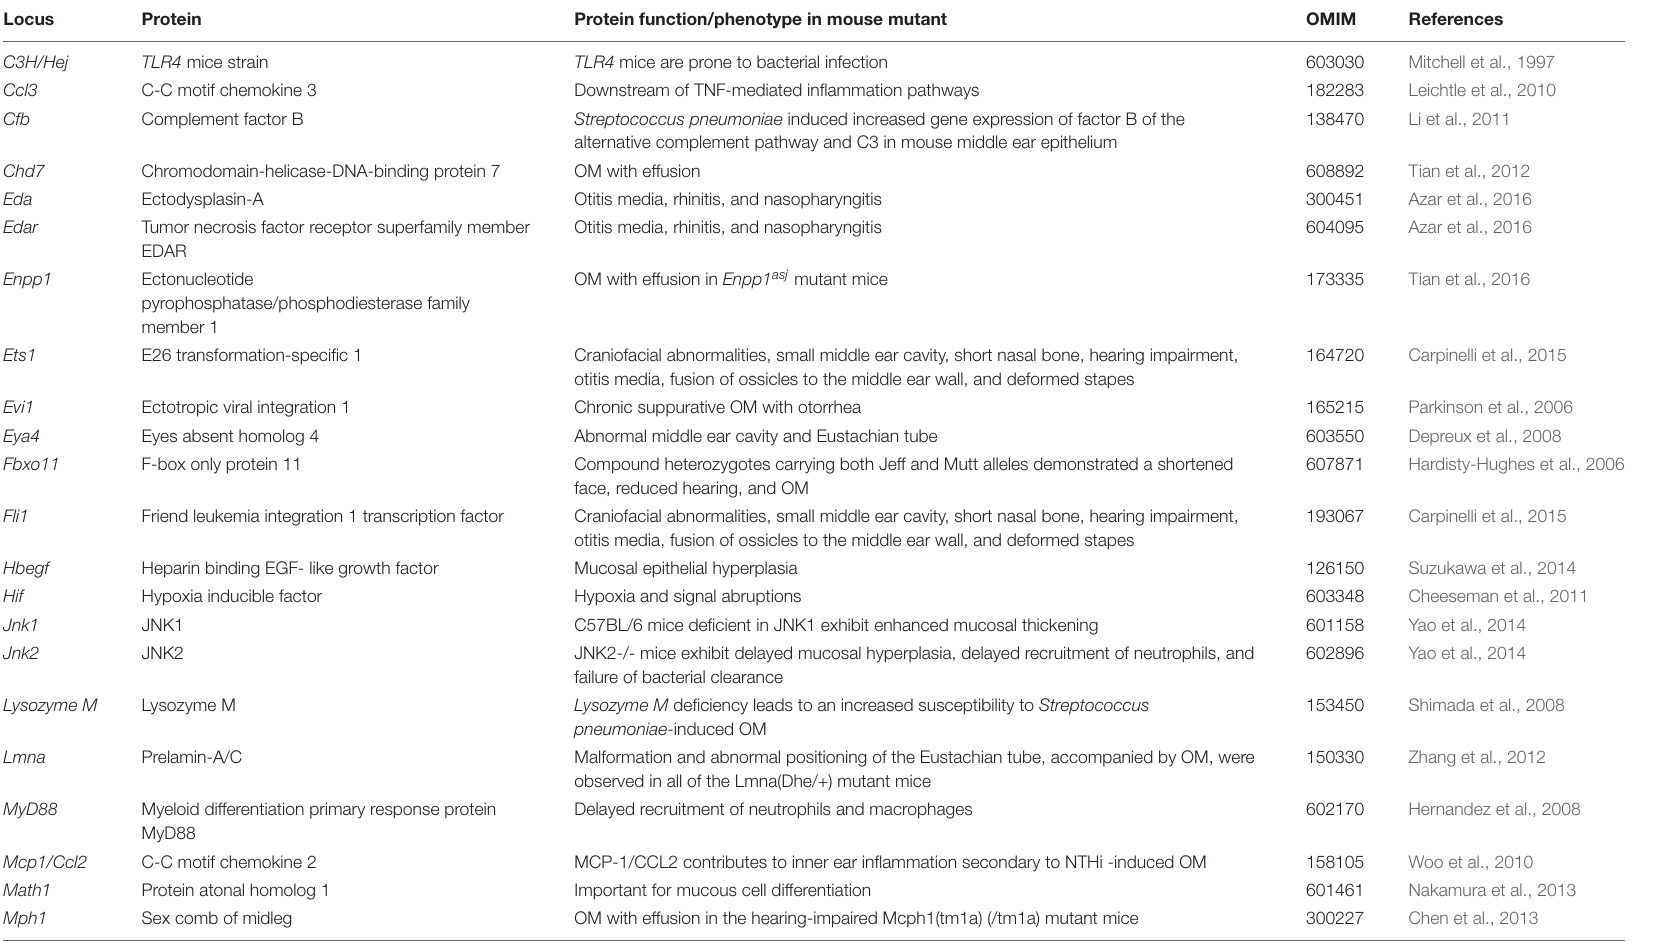
TABLE 1 | Most common loci associated with otitis media in mouse studies.